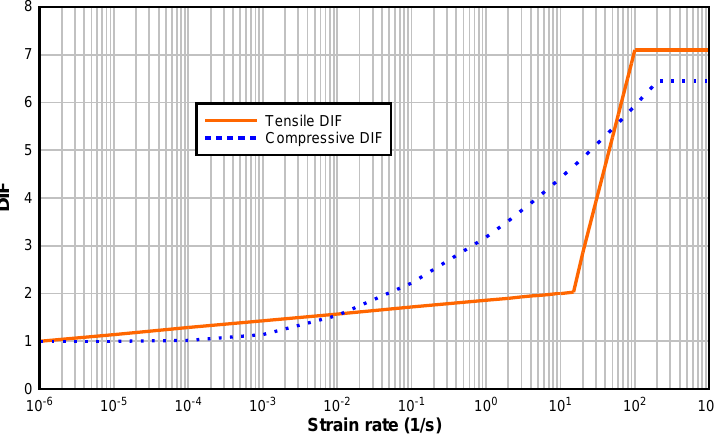
Figure 6. Tensile and compressive dynamic increase factor (DIF) curve used in the numerical model for asphalt concrete.